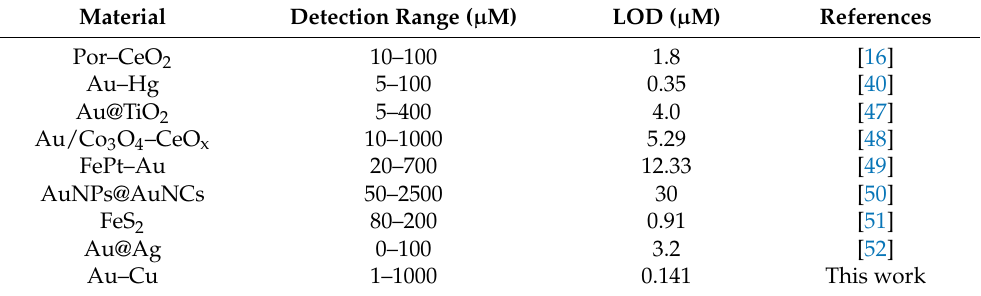
Table 1. Analytical parameters of H 2 O 2 detection in recent papers.